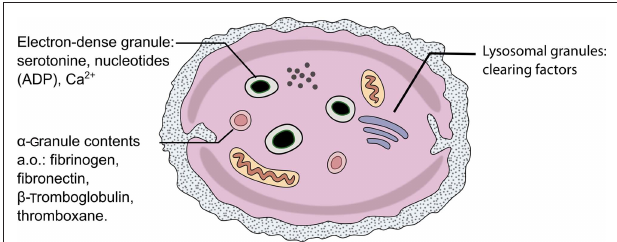
Figure 2 | Schematic drawing of a single platelet and its